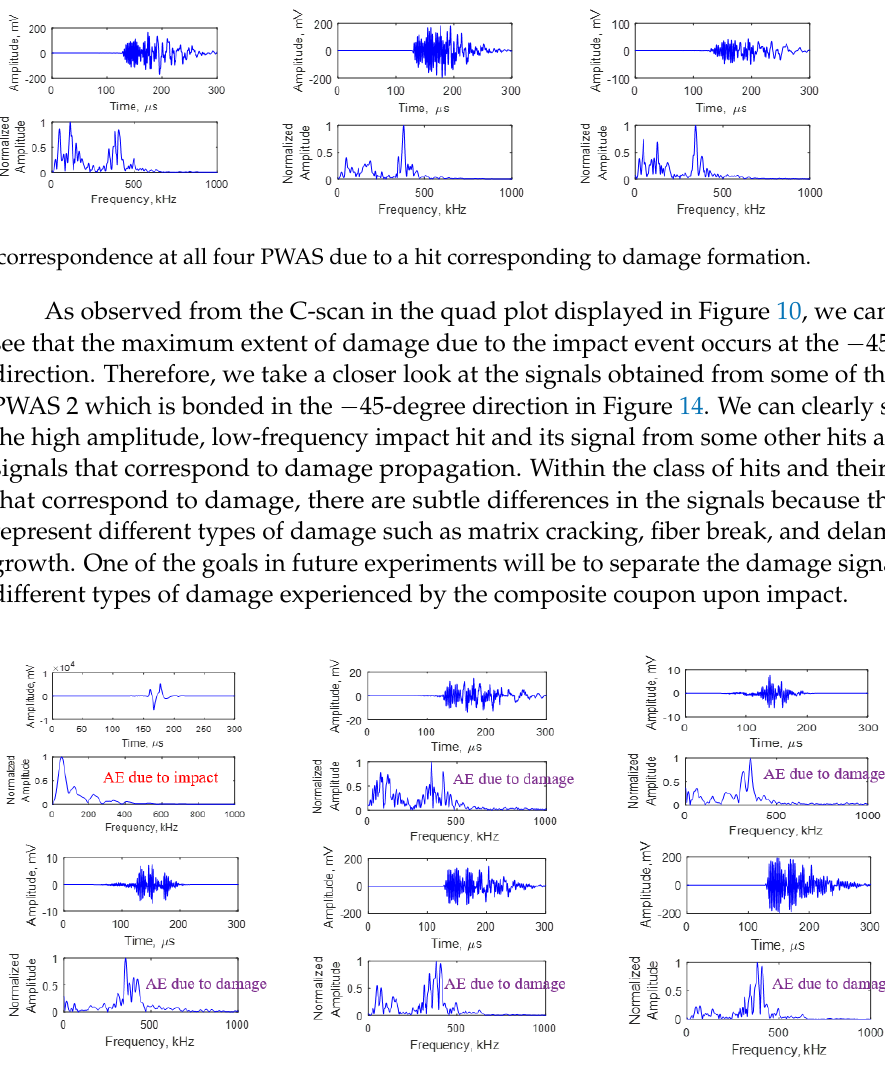
Figure 14. Various signals observed at PWAS2 due to the 16 J impact event.